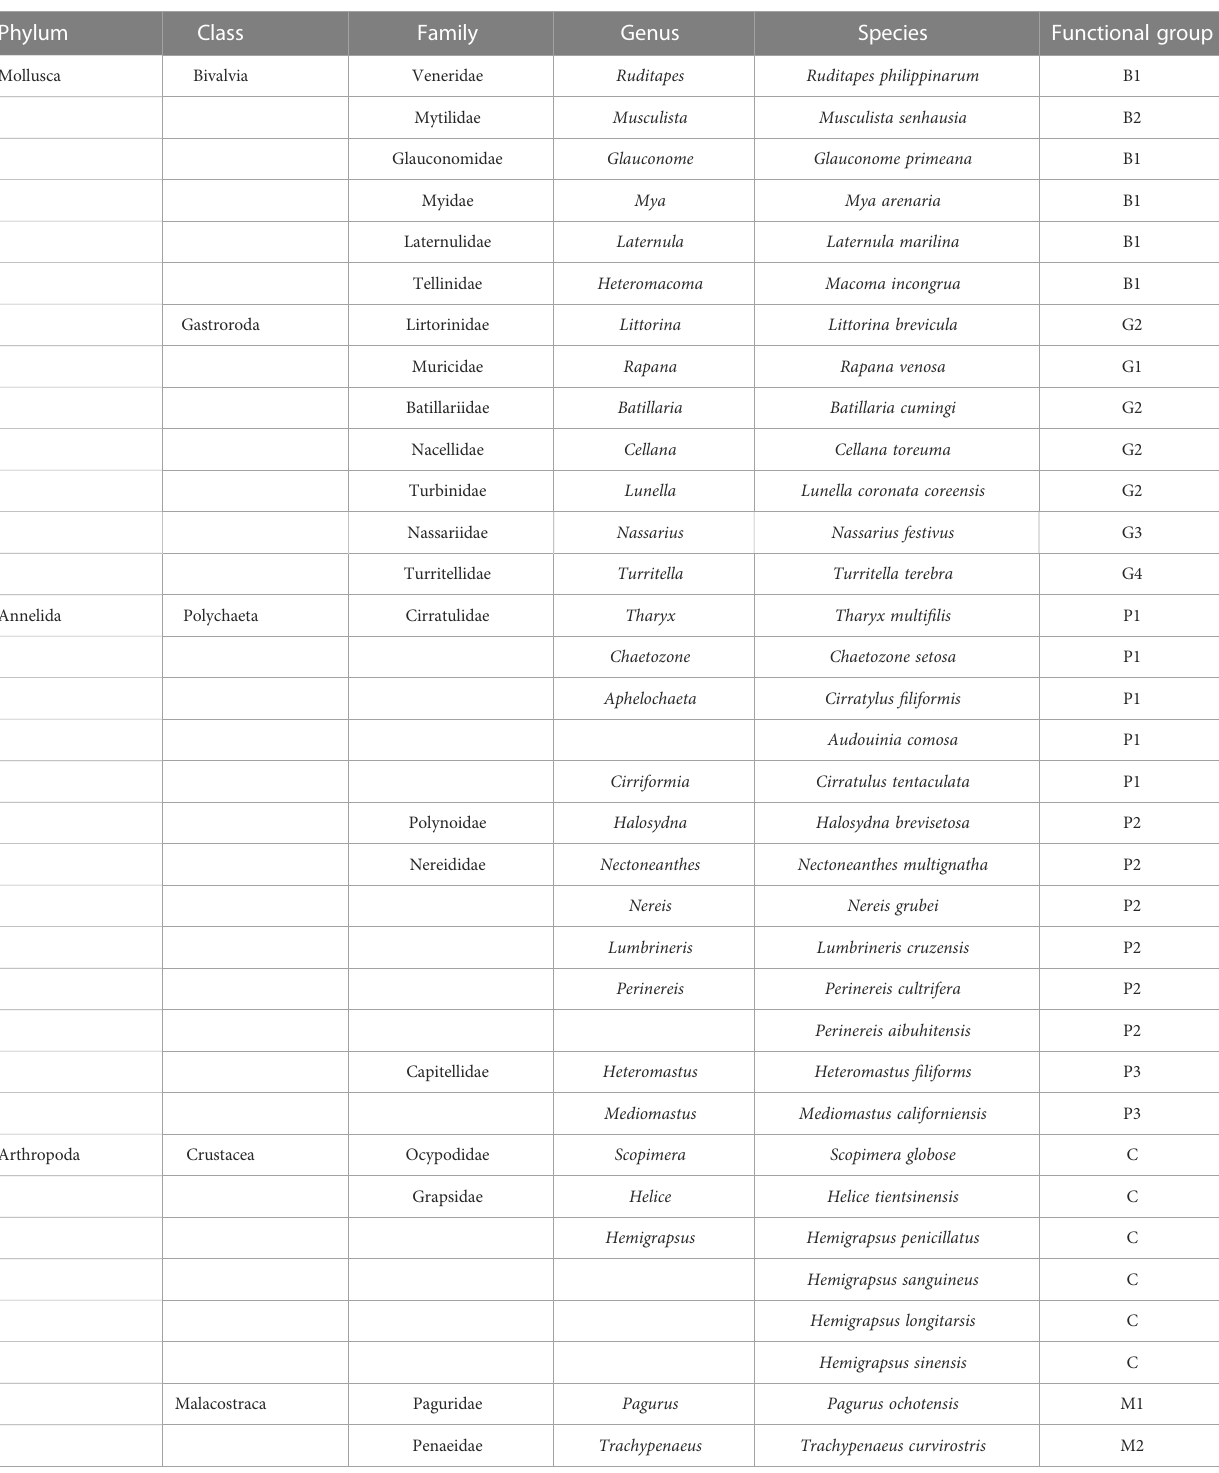
TABLE 3 Species and functional groups of macrobenthos in studied